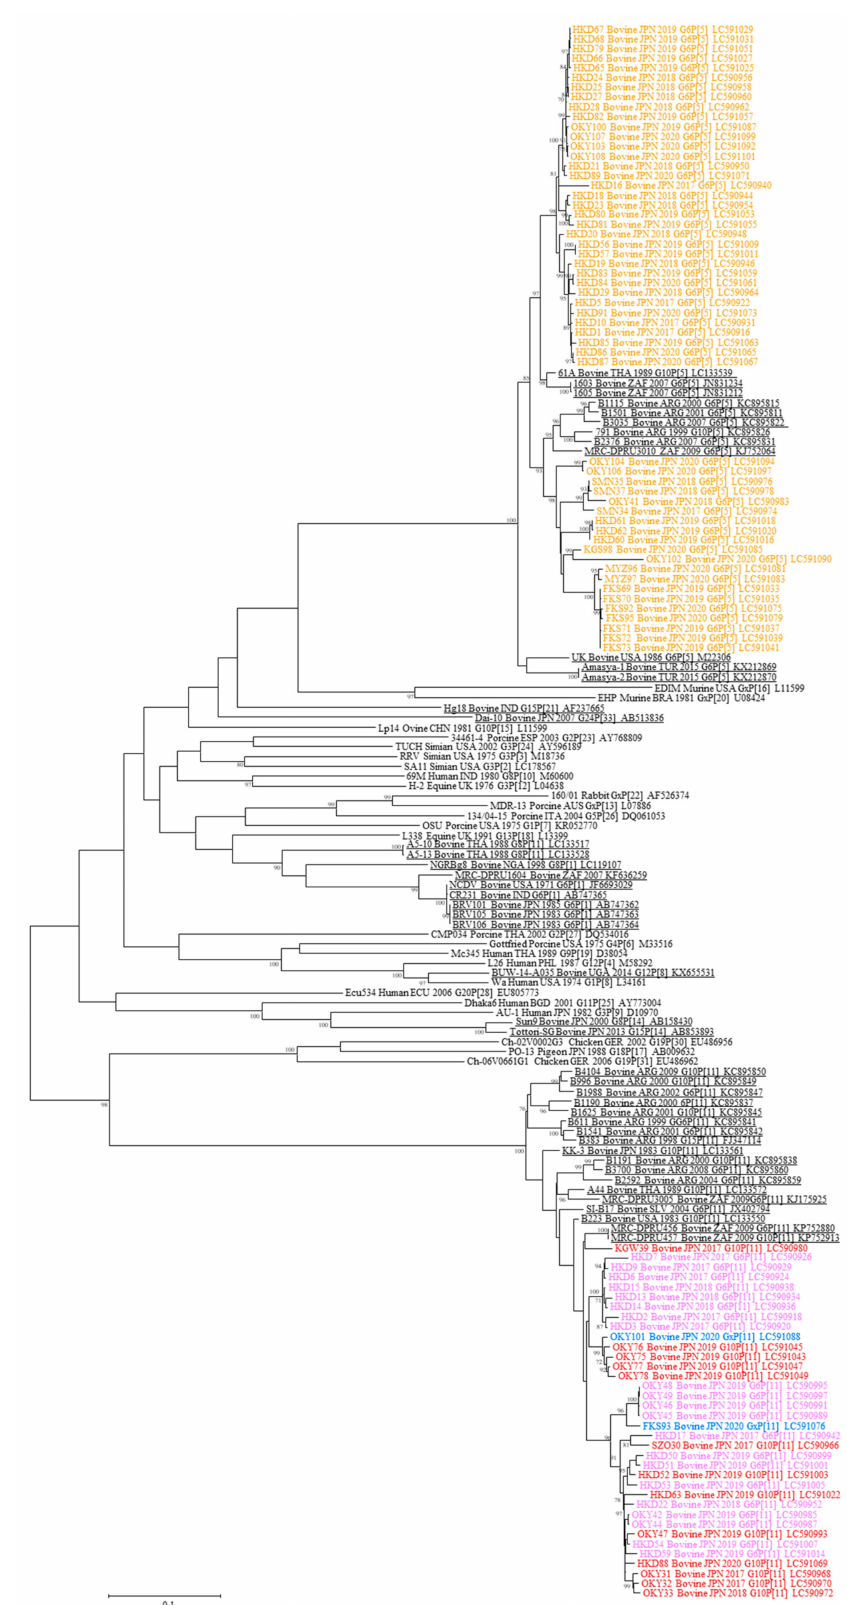
Figure 2. Phylogenetic tree based on the open reading frame (ORF) nucleotide sequences of rotavirus A (RVA) VP4. A phylogenetic tree was constructed using the maximum-likelihood method with